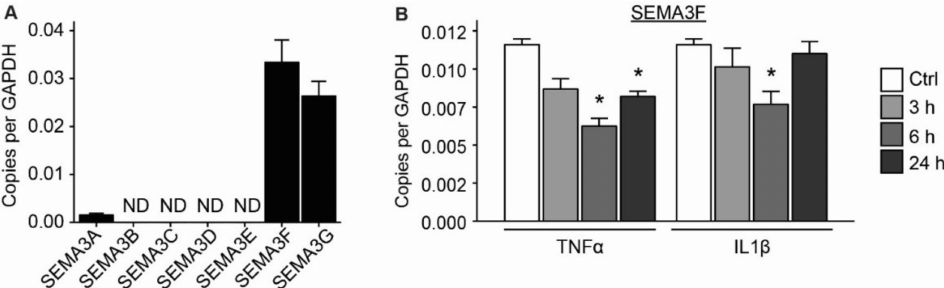
Figure 2. Confirmation of SEMA3F expression in human umbilical vein endothelial cells (HUVECs) and its response to inflammatory factors. ( A ) Quantification of expression of Class III semaphorins with qPCR in HUVECs. Results are presented as copy numbers per GAPDH, mean ± SEM, n = 3. ( B ) SEMA3F expression in HUVECs stimulated with the inflammatory factors, TNF α (10 ng / mL) or IL1 β (20 ng / mL). RNA was harvested 3, 6 and 24 h after stimulation started. Results are presented as copy numbers per GAPDH, mean ± SEM, n = 3, * p <